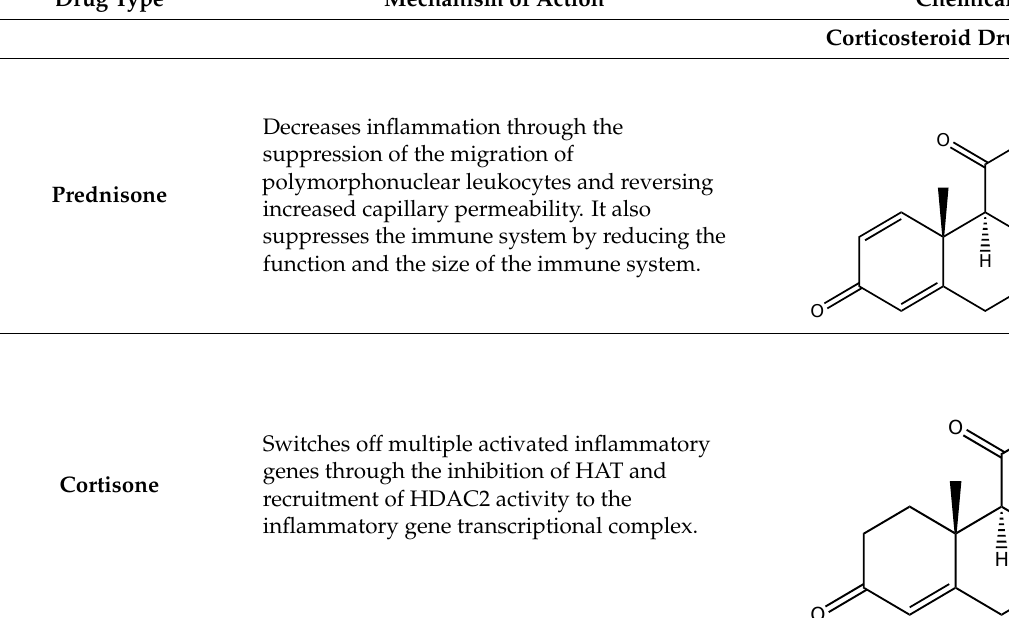
The methylprednisolone – glucocorticoid receptor complex binds and blocks promoter sites of pro-inflammatory genes, promotes the expression of anti-inflammatory gene products, and inhibits the synthesis of inflammatory cytokines, mainly by blocking the function of transcription factors, such as nuclear factor kappa-B